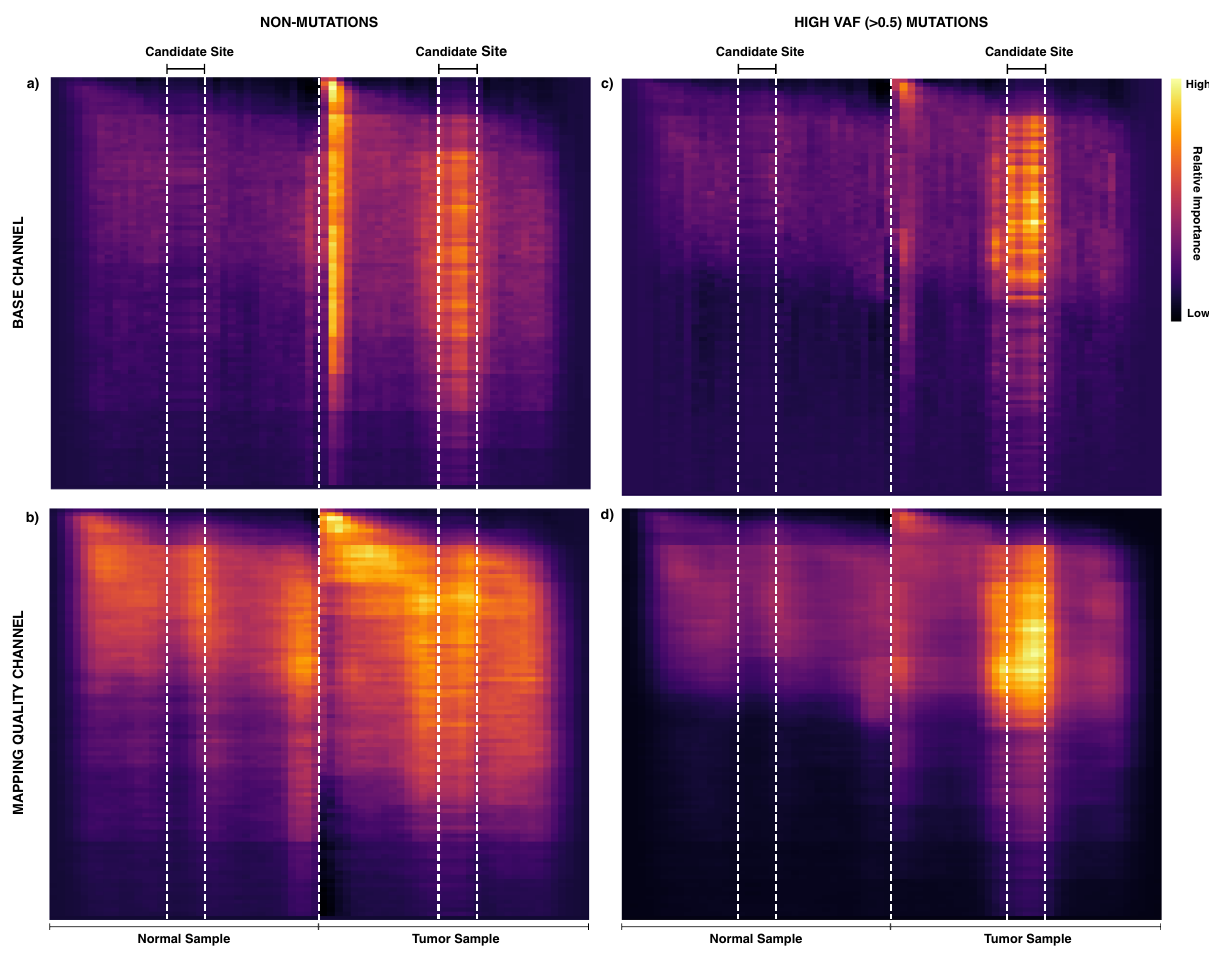
Fig. 6 Model activation at mutated and non-mutated sites. Pixel importance scores are computed for individual sites using Guided Backpropagation 11 . Importance scores were averaged across 1000 randomly selected sites from the training set. a , b Heatmap of averaged pixel importance at non-mutated sites for the base and mapping quality channel, respectively. c , d Heatmap of averaged pixel importance at High-VAF-mutated sites for the base and mapping quality channel, respectively. Visualizations for other input feature channels are provided in Supplementary Fig.